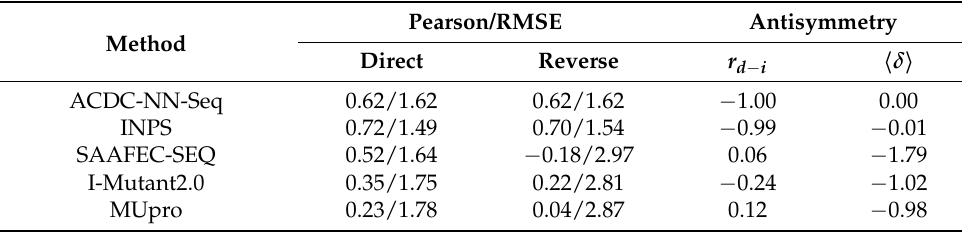
Table 6. Results on p53: Comparison on p53. The INPS, SAAFEC-SEQ and I-mutant2.0 results were obtained using their stand alone code, those of MUpro were obtained using the webserver available.